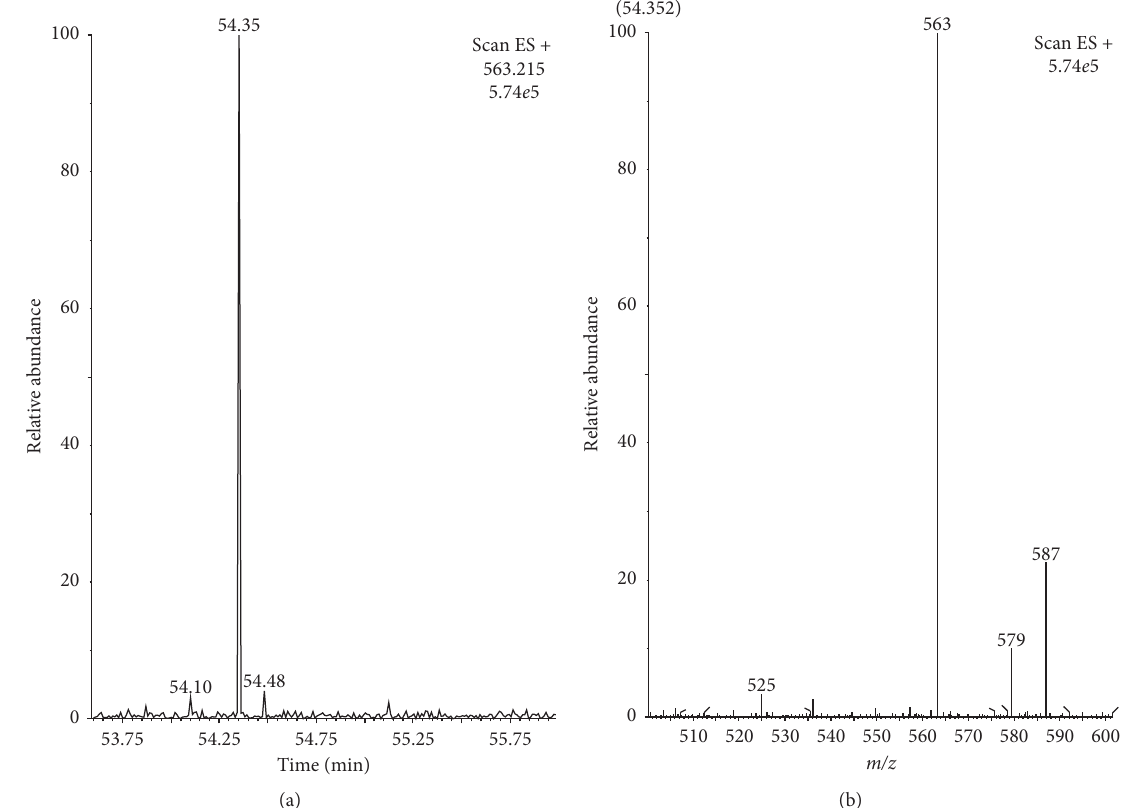
Figure 4: Extracted ion chromatogram (a) and the corresponding mass spectrum (b) based on the molecular ion at m / z 563 that could arise from amide adduct 10 or from the corresponding amide adduct from secosterol aldehyde 3 .